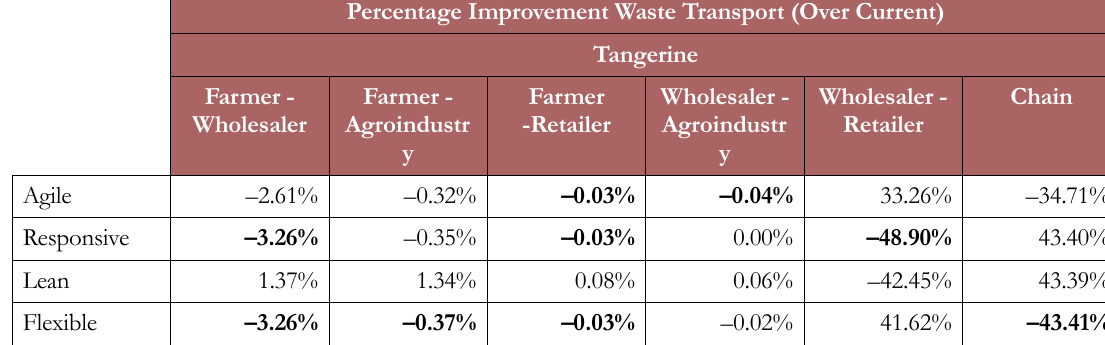
Table 6c. Waste Transport for